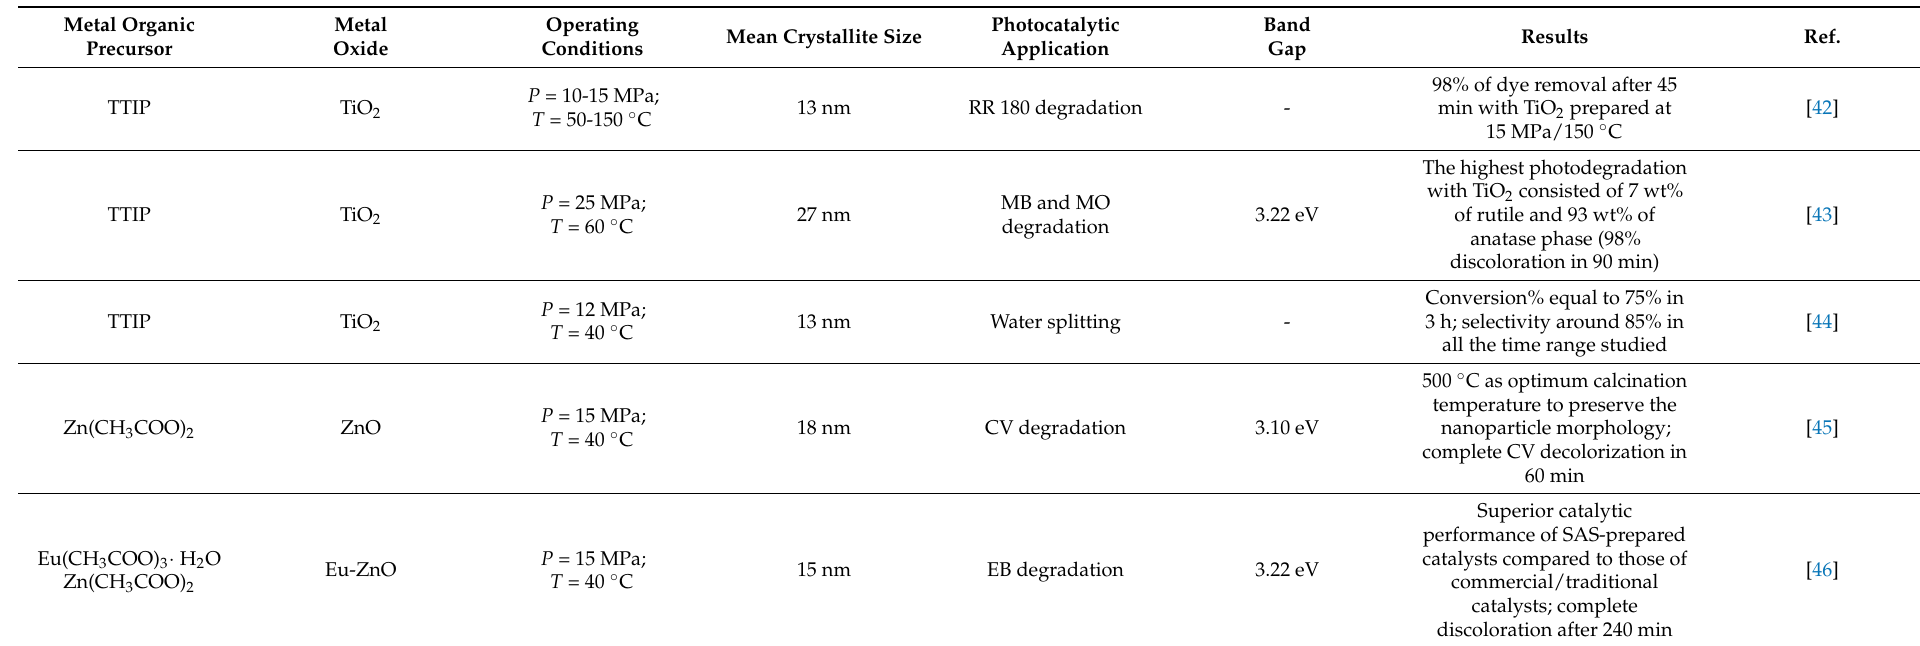
Table 2. Production of photocatalysts by SAS precipitation. CV = crystal violet; RR 180 = reactive red 180; EB = eriochrome black-T; MB = methylene blu; MO = methyl orange; titanium tetraisopropoxide (TTIP); P = operating pressure; T = operating